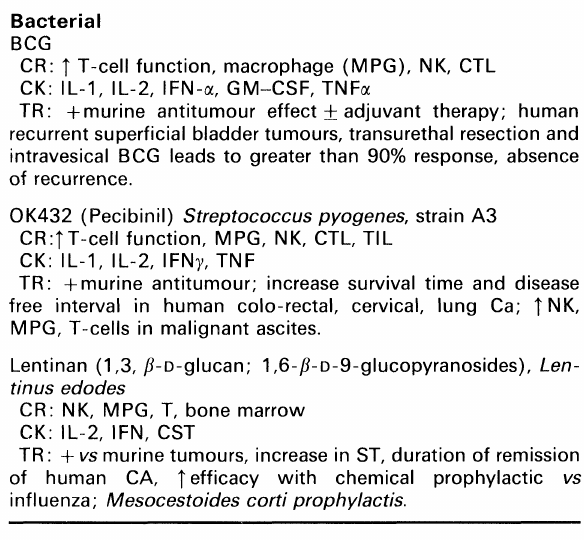
Table 7. Characterization of biological response modifiers relative to cell regulated, cytokine and disease treatment Bacterial BCG